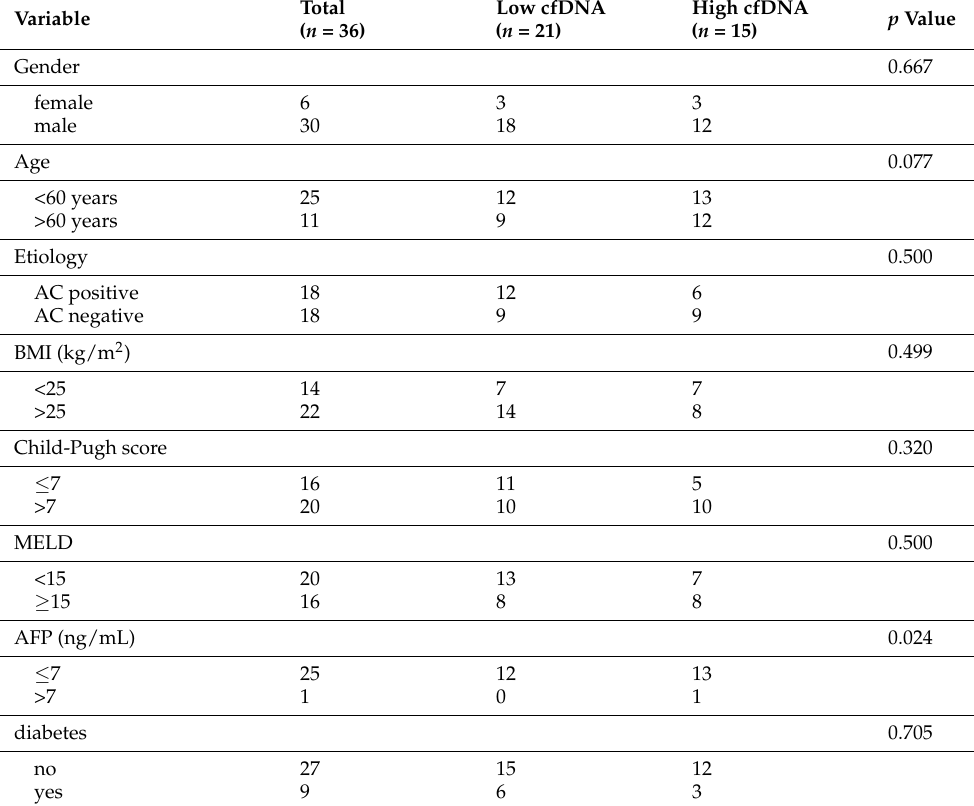
Table 7. Association between cfDNA and patients’ characteristics. No significant association was found between the amount of cfDNA and patients’ clinical characteristics, with the only exception of AFP ( p =